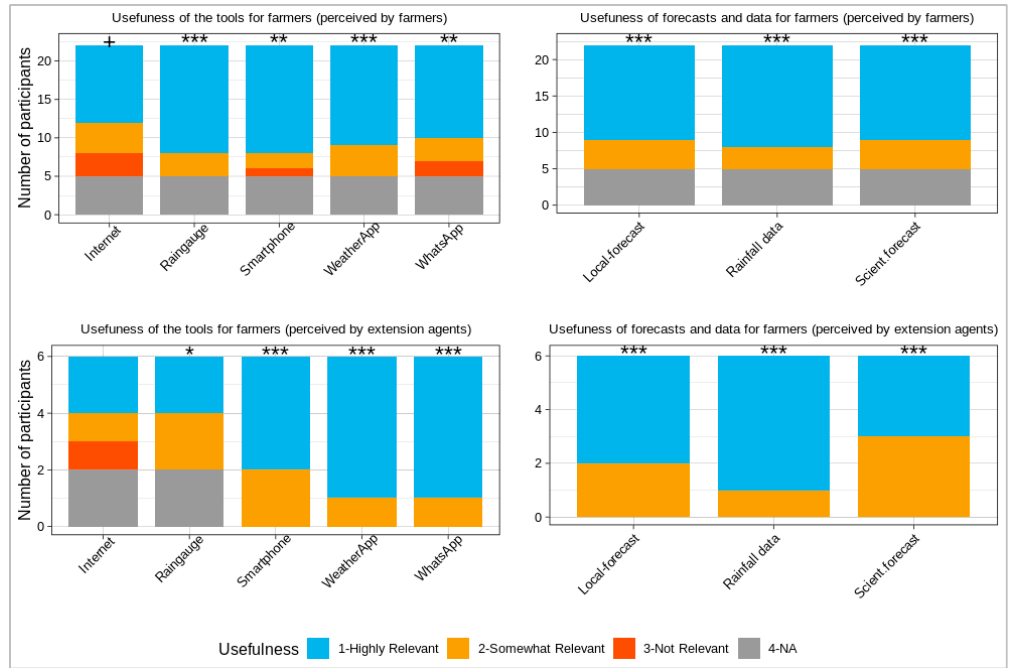
Figure 8. Farmers’ perceptions of the relevance or usefulness of the digital tools and weather forecast information and data shared compared to channels formerly used for dissemination of forecast data. “NA” indicates the share of participants who abstained from answering the question or dropped out of the experiment. Farmers were asked how useful the tools and information were, while extension agents were asked to confirm this usefulness. Various symbols (+, *, **, and ***) indicate the significance of the results for the combined “somewhat and highly relevant” category at, respectively, p < 0.1, p < 0.05, p < 0.01, and p < 0.001, based on a binomial distribution test.